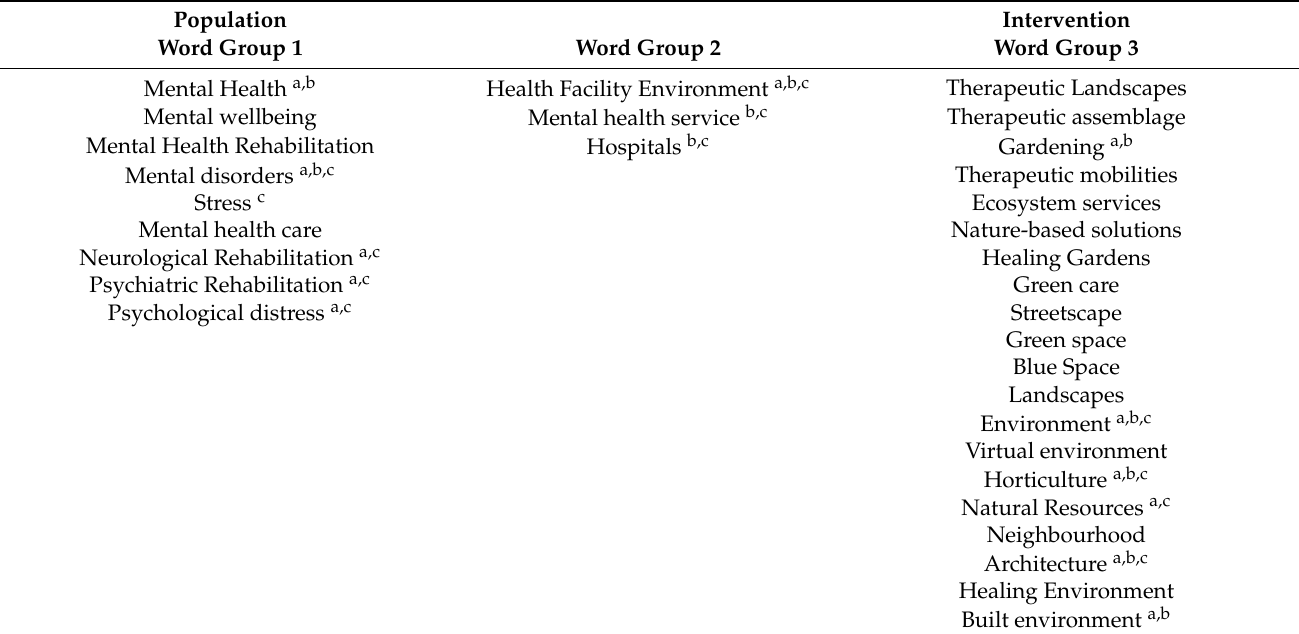
Table 1. Search terms used in the electronic search using PICO